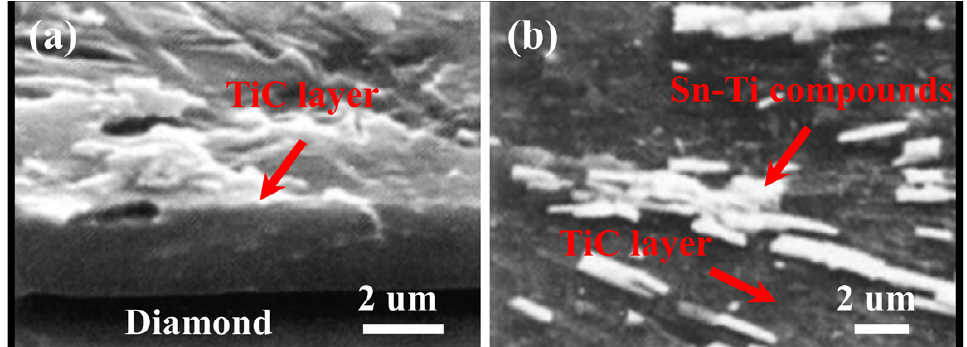
Figure 14. SEM morphology of diamond surface after brazing: ( a ) TiC layer, ( b ) surface of TiC layer. Reprinted with permission from Ref. [60] . Copyright 2012, Springer.